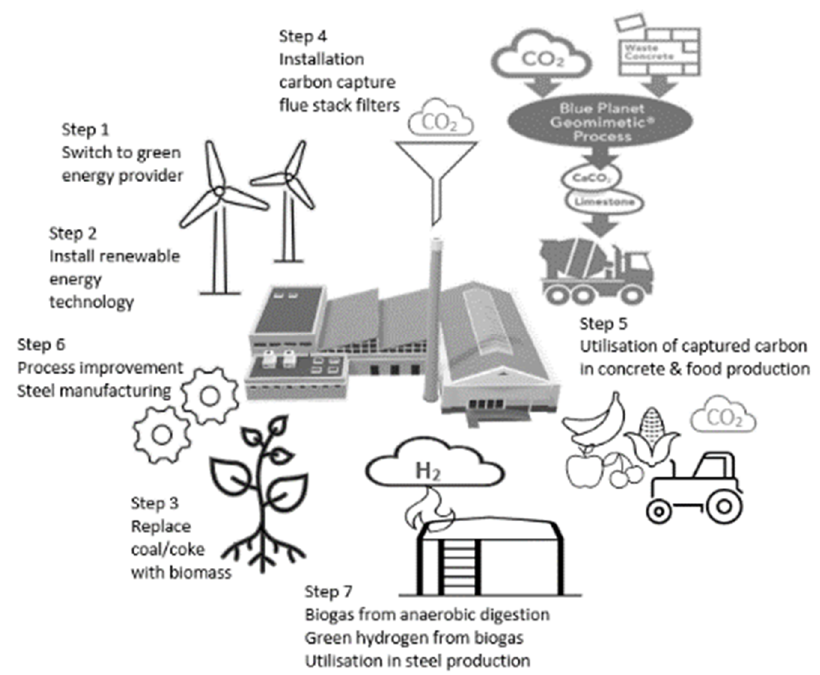
Figure 5. The seven steps to net-zero steel production.